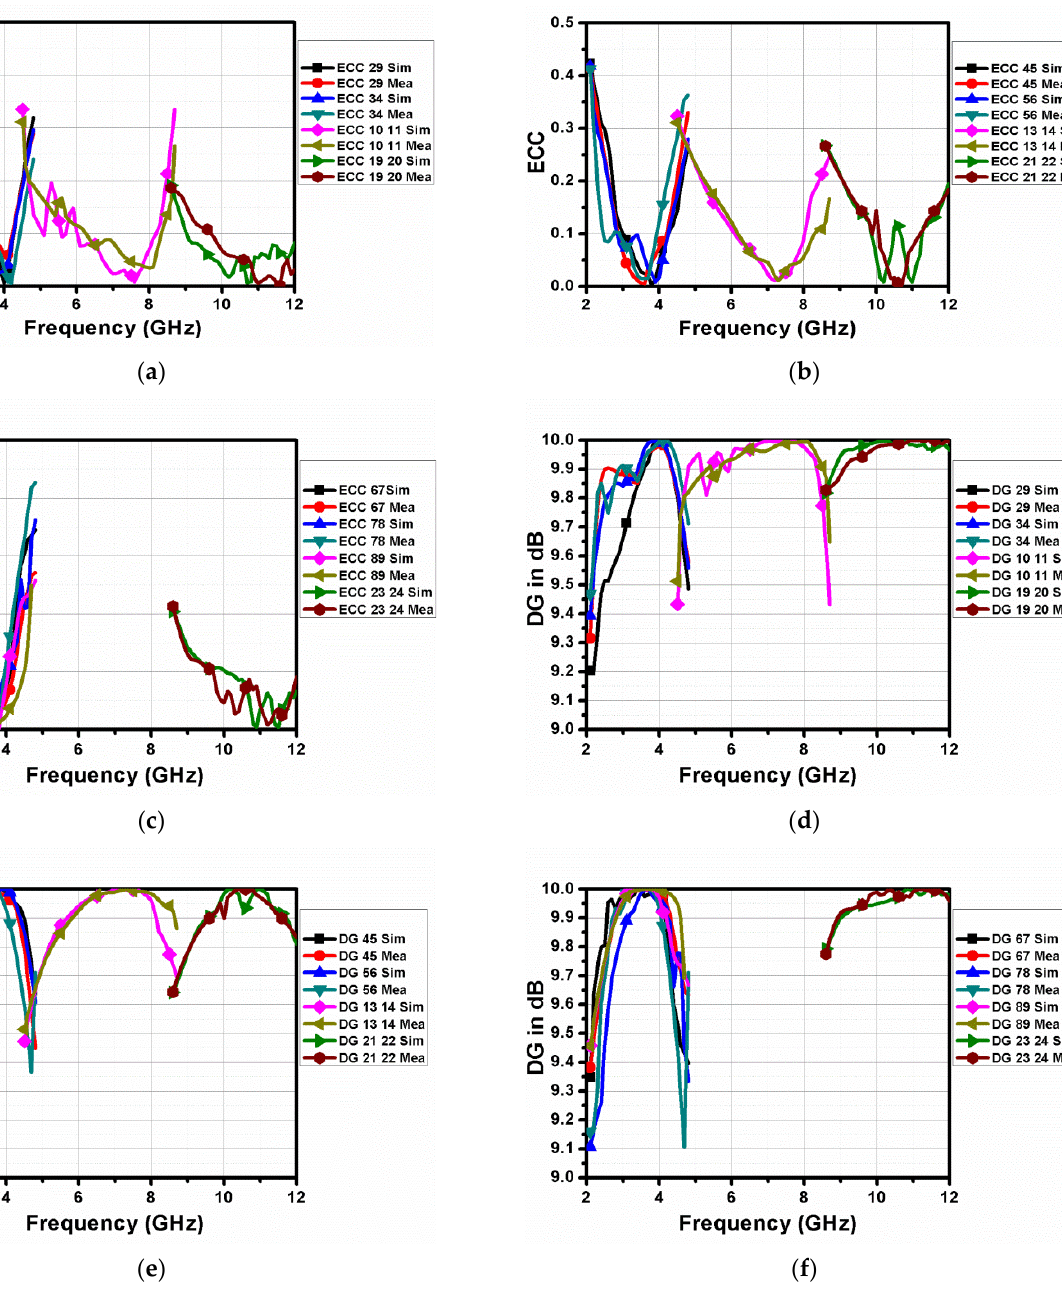
Figure 33. ECC and DG of the 25-port CR MIMO antenna. ( a ) ECC 29, ECC 34, ECC 10 11 and ECC 19 20( b ) ECC 45, ECC 56, ECC 13 14 and ECC 21 22 ( c ) ECC 67, ECC 78, ECC 89 and ECC 23 24 ( d ) DG 29, DG 34, DG 10 11 and DG 19 20 ( e ) DG 45, DG 56, DG 13 14 and DG 21 22 ( f ) DG 67, DG 78, DG 89 and DG 23 24